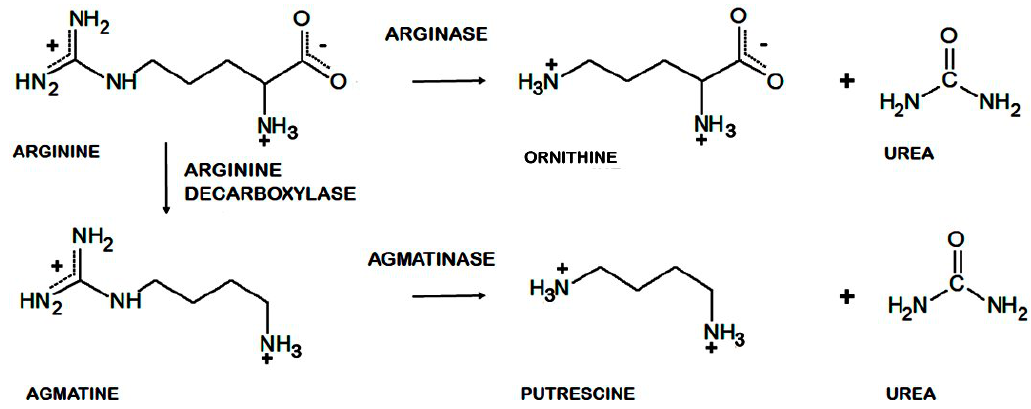
Figure 1. Reactions catalyzed by arginase, agmatinase, and arginine decarboxylase. Arginase, in addition to its participation in the last reaction of the urea cycle, participates in the regulation of cellular concentrations of arginine and ornithine. The last are essential for the synthesis of nitric oxide, creatine, glutamate, proline, and the polyamines putrescine, spermine, and spermidine. In higher animals, arginase exists in two isoenzymatic forms, which share an approximate 60% similarity in their amino acid sequence, where arginase I is cytosolic and predominant in the liver, while the type II enzyme is mitochondrial and characteristic of extrahepatic tissues, predominantly kidney and prostate [1–7].